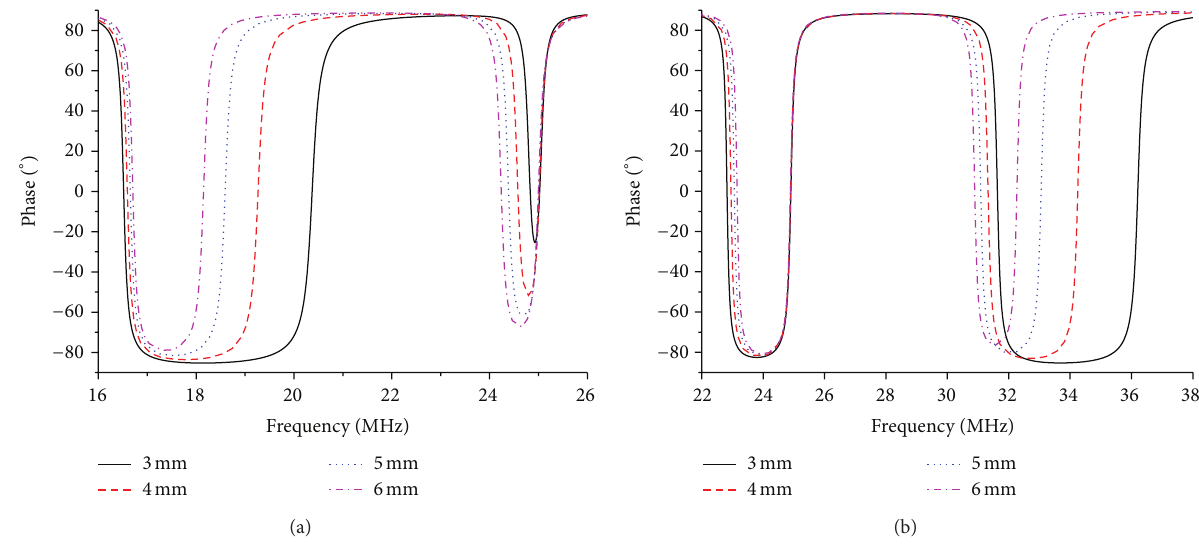
Figure 11: Test result of moving (a) coil 1 outward, (b) coil 2 inward.